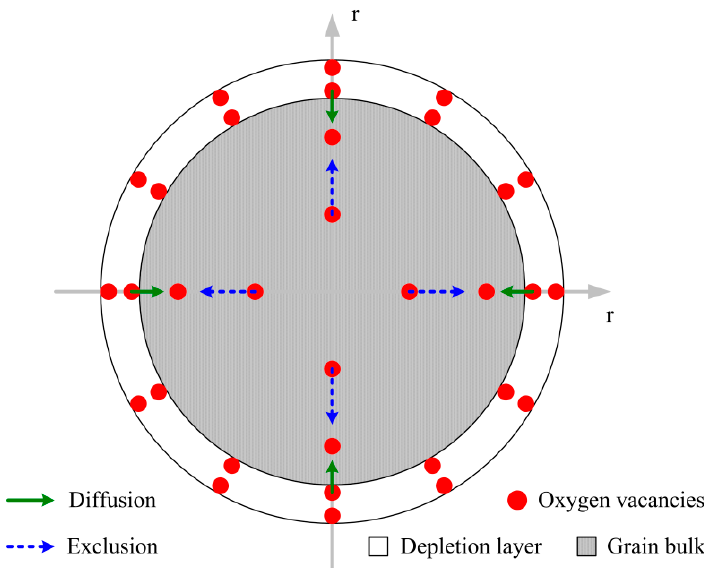
Figure 1. Schematic drawing of the migration of oxygen vacancies under the diffusion and exclusion effects in a sphere coordinates established in an ideal grain.